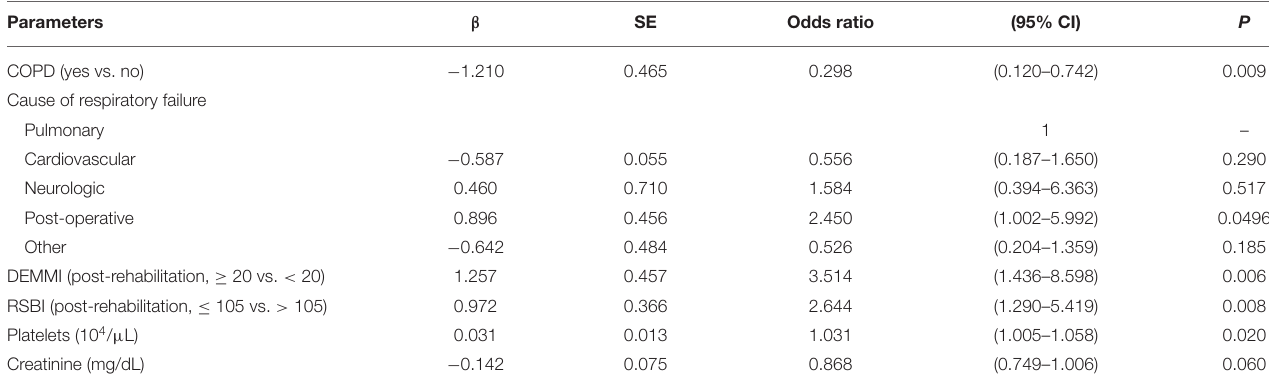
TABLE 3 | Multivariate logistic regression models for significant clinical characteristics associated with weaning success at RCC discharge * . Parameters β